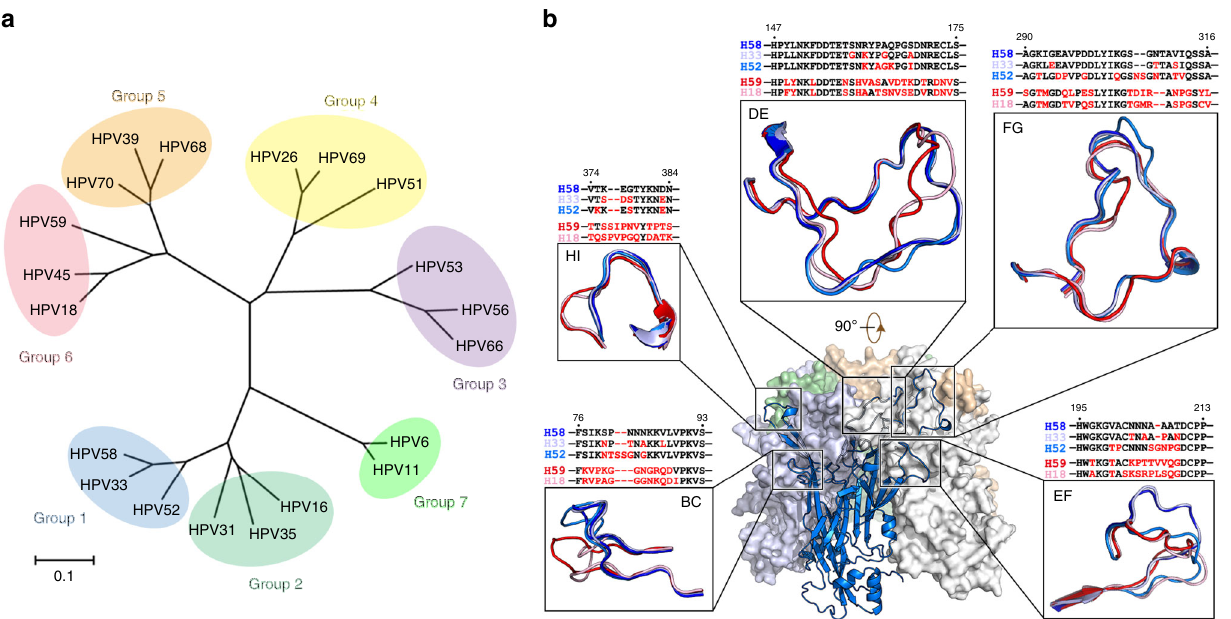
Fig. 1 Phylogenetic classi fi cation among the major capsid proteins (L1) of multiple types, and a structural comparison of HPV L1s. a Phylogenetic tree of HPV L1 proteins based on the amino acid sequences of 20 HPV types. The bar at the bottom provides a scale for the change in evolutionary lineages over time. Twenty HPV types were divided into seven groups based on evolutionary distance of their L1 proteins: Group 1 (blue): HPV33, -52 and -58; Group 2 (cyan): HPV16, -31 and -35; Group 3 (purple): HPV53, -56 and -66; Group 4 (yellow): HPV26, -51 and -69; Group 5 (orange): HPV39, -68 and -70; Group 6 (pink): HPV18, -45 and -59; and Group 7 (green): HPV6 and -11. b Structural comparison of loop structure among HPV types of HPV33, -58 (PDB code: 5Y9E), -52, -18 (PDB code: 2R5I), and -59 (PDB code: 5J6R). The loops are colored by type: HPV33 (light blue), HPV58 (deep blue), HPV52 (marine), HPV18 (light pink) and HPV59 (red). The loop sequence alignments among types are shown above the corresponding loop structure, with residue differences compared with HPV58 colored red